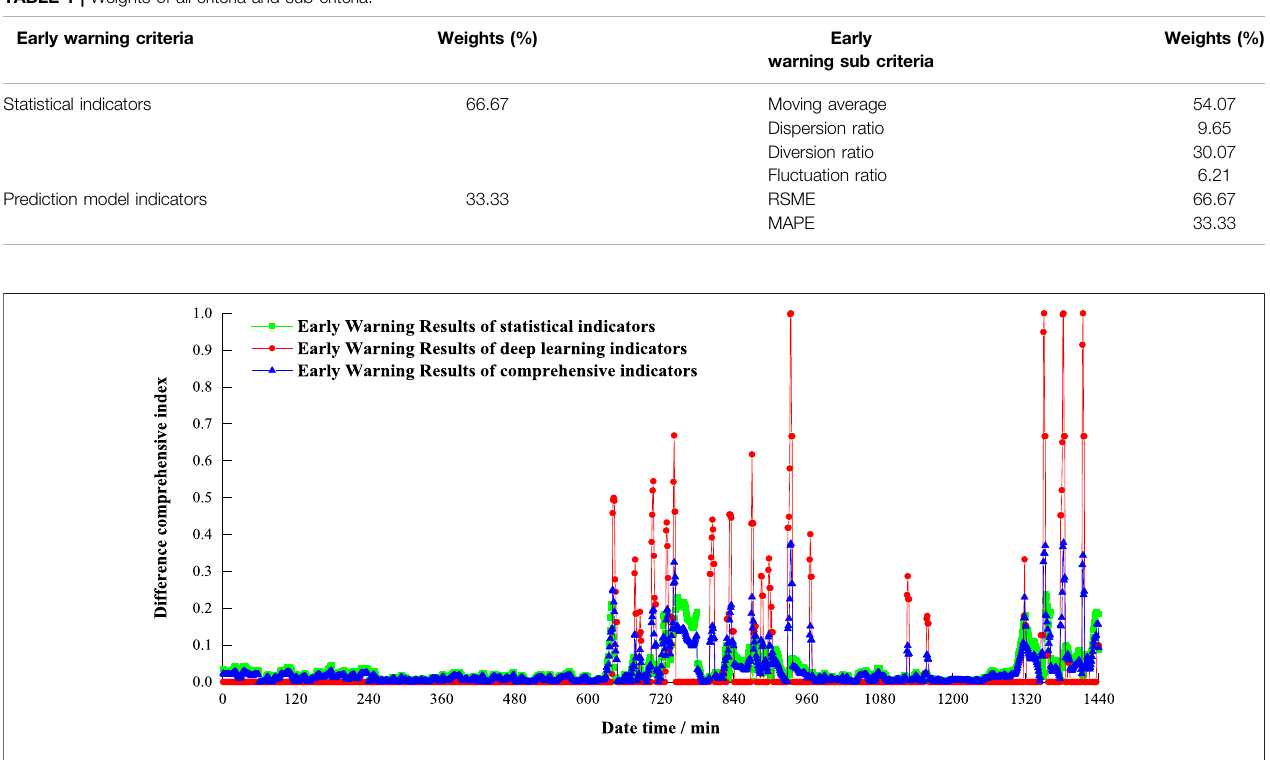
FIGURE 14 | Analysis of outburst warning results on March